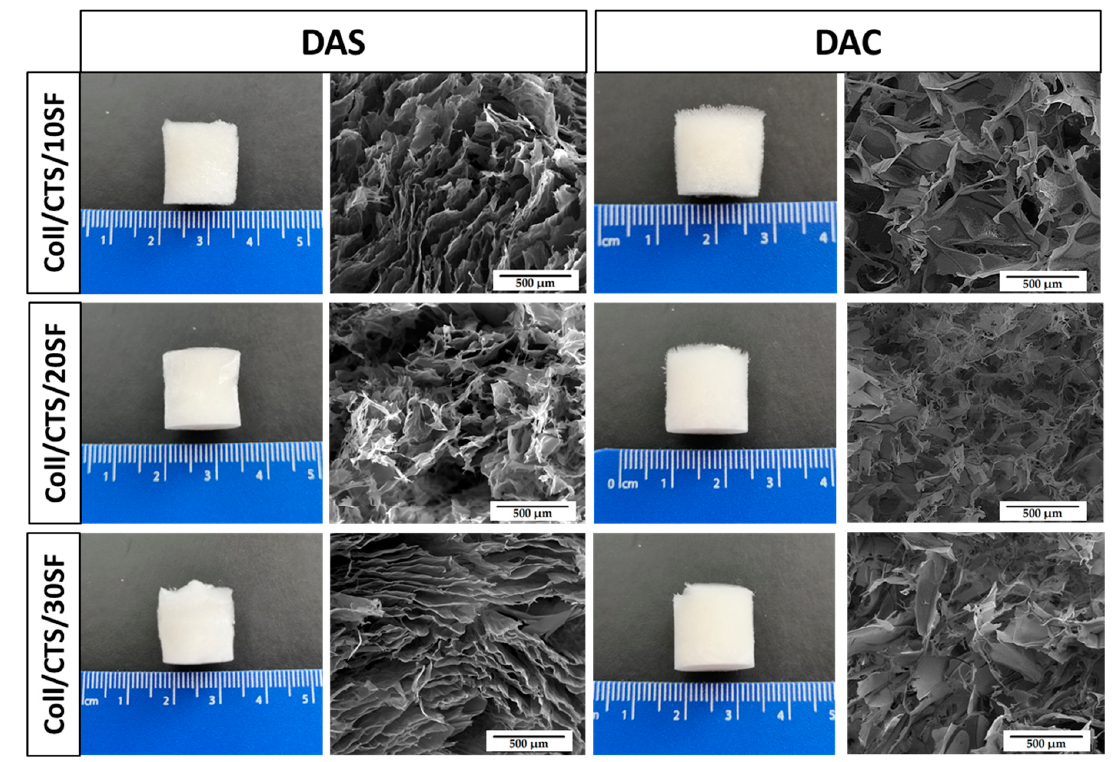
Figure 8. Macroscopic appearance and SEM micrographs of 50/50 Coll/CTS scaffolds with 10, 20 and 30% addition of silk fibroin cross-linked with dialdehyde starch (DAS) and dialdehyde chitosan (DAC).